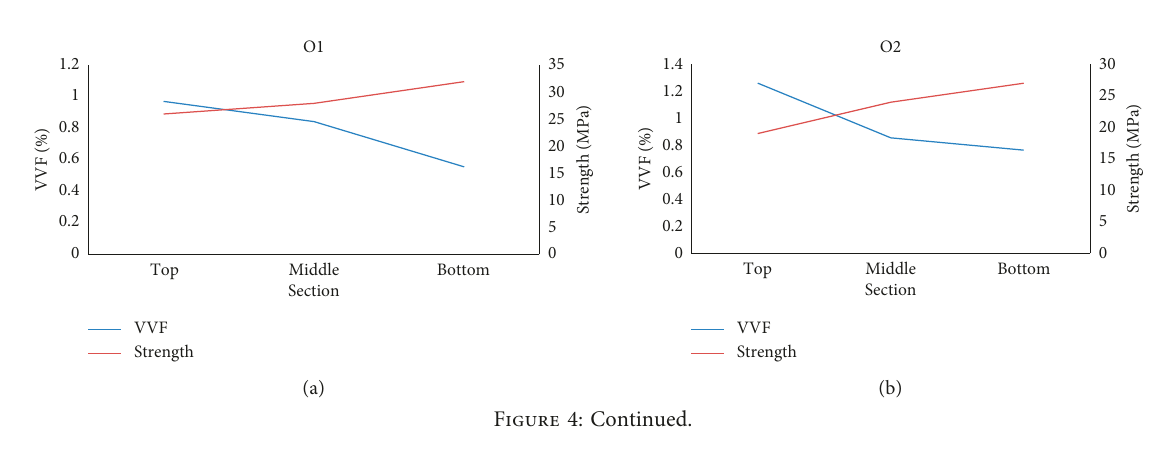
Figure 3: Void analysis results of the concrete specimens.